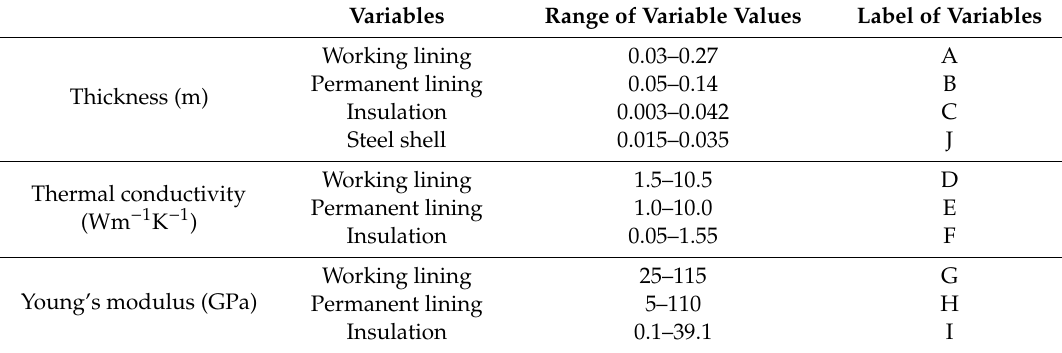
Table 2. Geometrical and material property variables of steel ladle [26].